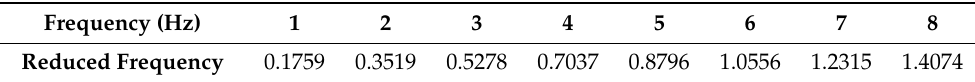
Table 3. Frequency and corresponding reduced frequency.